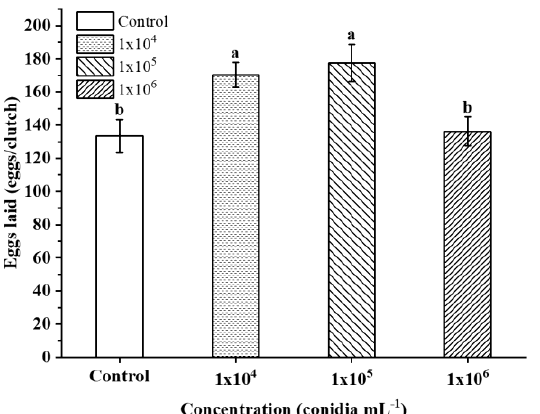
Figure 5. Eggs laid off S. guani under different concentrations of B. bassiana spore suspension. Different letters above the bars indicate significant differences (mean ± SE, n = 30 in each treatment, p < 0.05).